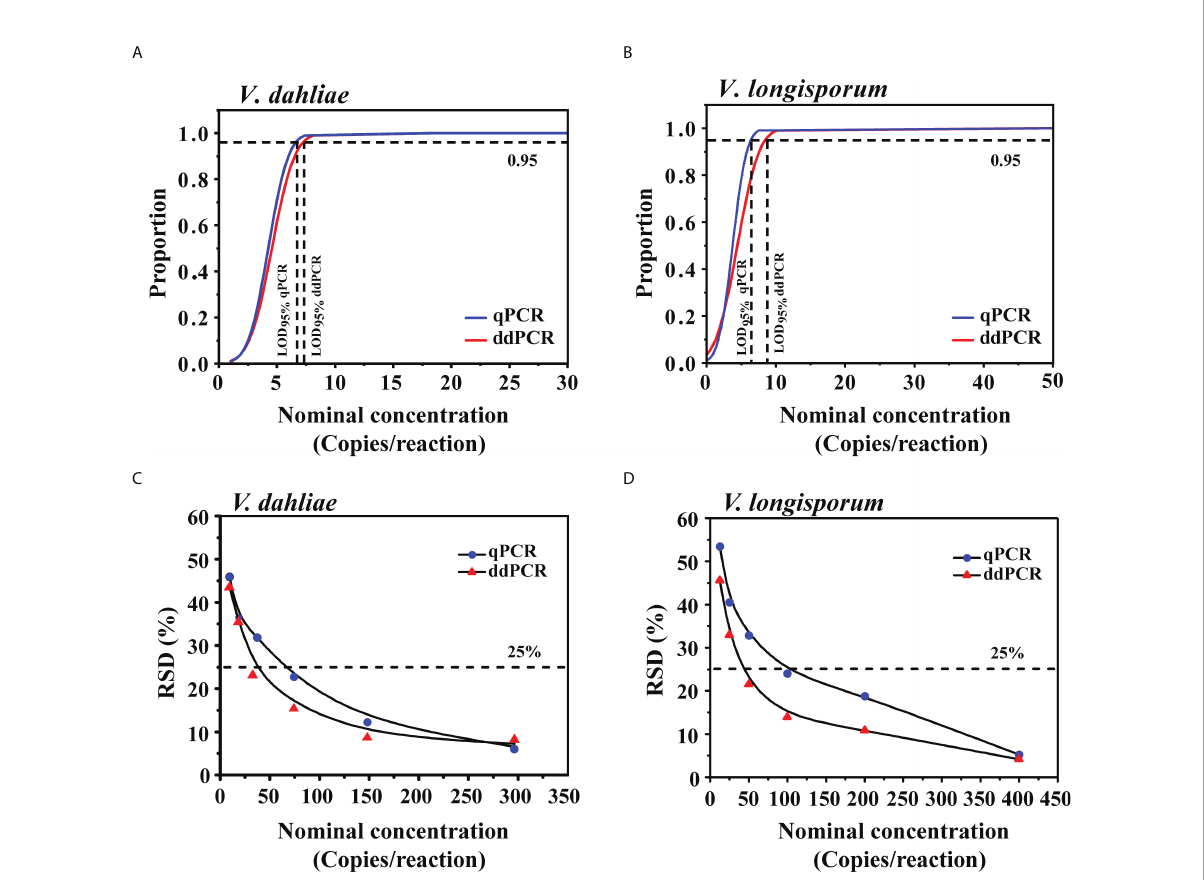
FIGURE 4 Comparison of LoD 95% and measurement precision for the qPCR and ddPCR to quantify V. dahliae and V. longisporum . (A, B) Determination of LoD 95% of qPCR and ddPCR by probit analysis. The y -axis shows the fraction of positive results in 10 parallel reactions for each given concentration indicated on the x -axis. Horizontal dashed lines indicate the dilution level where the estimated probability of detection is 95% (LoD 95% ). (C, D) RSD of qPCR and ddPCR at each low-concentration dilution level. The horizontal dashed lines indicate RSD =